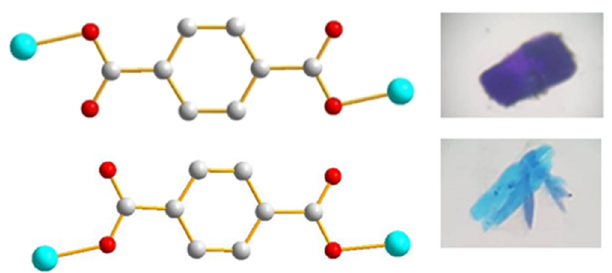
Figure 7. The trans (top) and cis (bottom) configuration of the 1,4-BDC 2 − ligands in 5a and 5b · H 2 O as well as their purple and blue crystals.